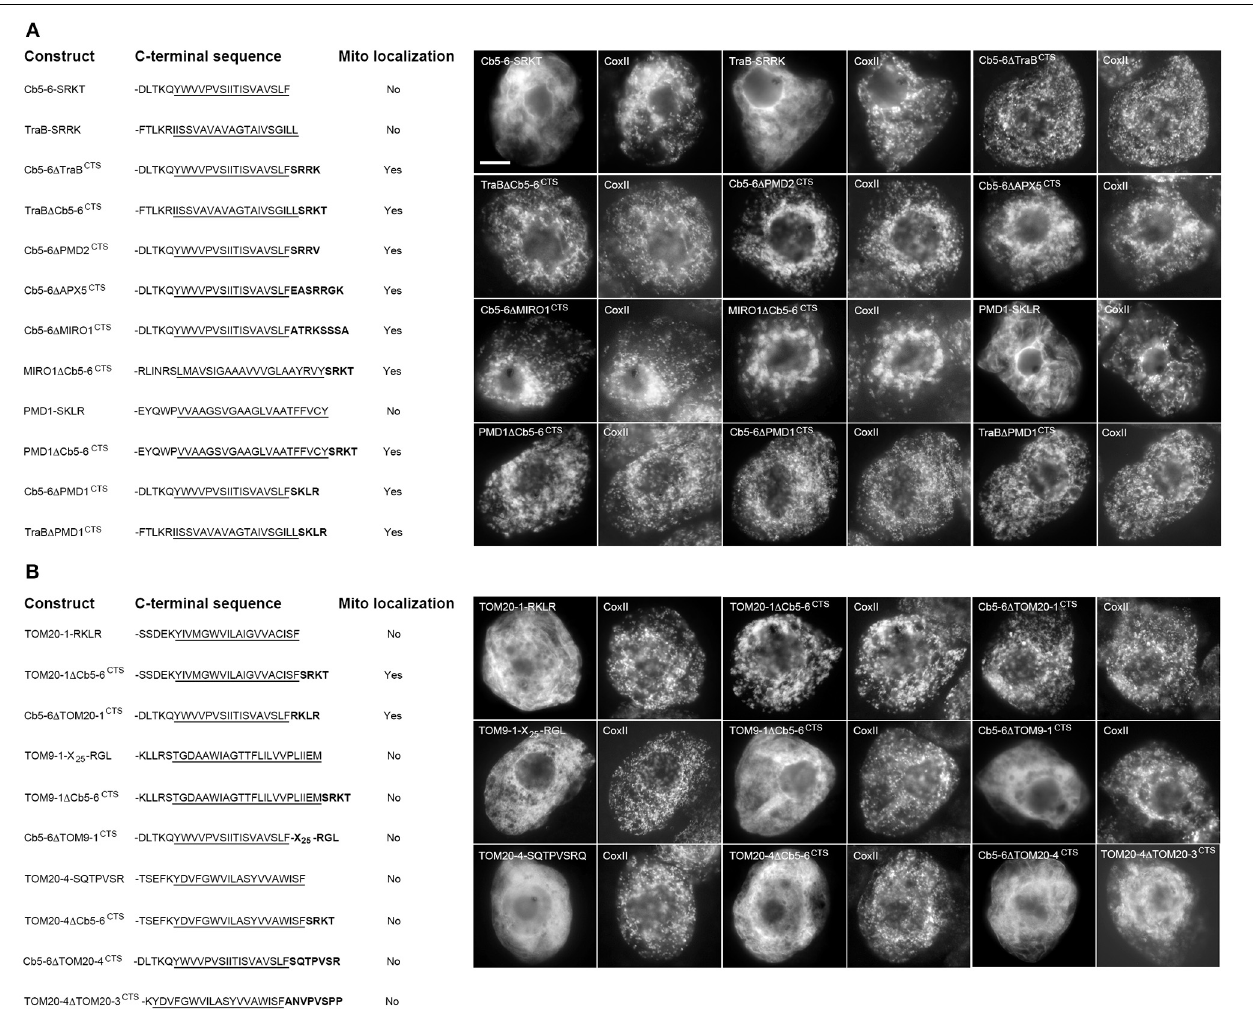
FIGURE 4 | Localization of various CTS mutants and hybrid versions of selected mitochondrial-TA proteins in BY-2 cells. Shown on the left in both (A) and (B) are schematic illustrations of various CTS mutant (truncated) or hybrid versions of selected dibasic-motif-containing TA proteins (A) and/or TOM-TA proteins (B) and their corresponding localization (or lack thereof) to mitochondria in transformed BY-2 cells. The names of the mutant and hybrid constructs represent either the specific amino acids in the CTS that were deleted from the protein or replaced with the CTS from another protein. All constructs possess an N-terminal-appended Myc-epitope tag. Shown for